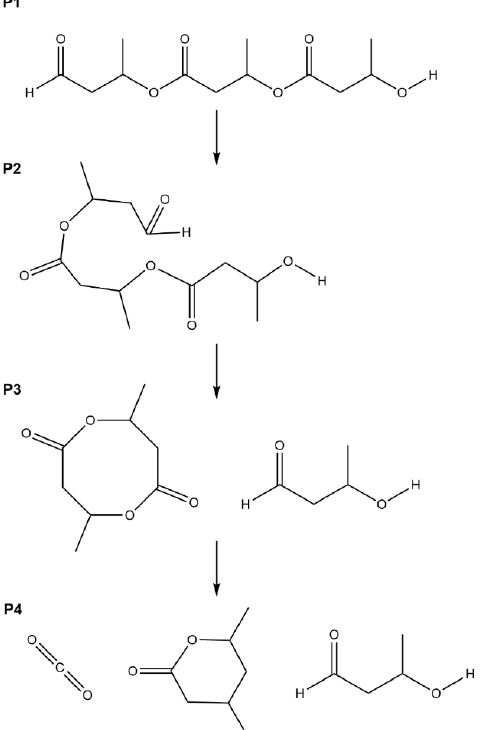
Figure 3. Mechanism of the thermal degradation of polyhydroxybutyrate (PHB): substrate (P1), intermediate structures (P2, P3) and the final product (P4).